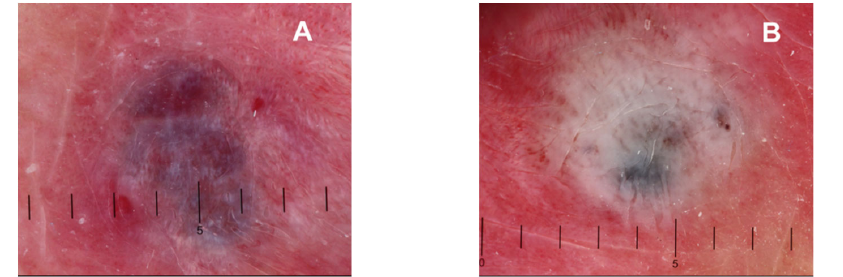
Figure 1. Dermatoscope view with a millimeter scale of a venous lake before the laser application ( A ) and immediately after the laser application ( B